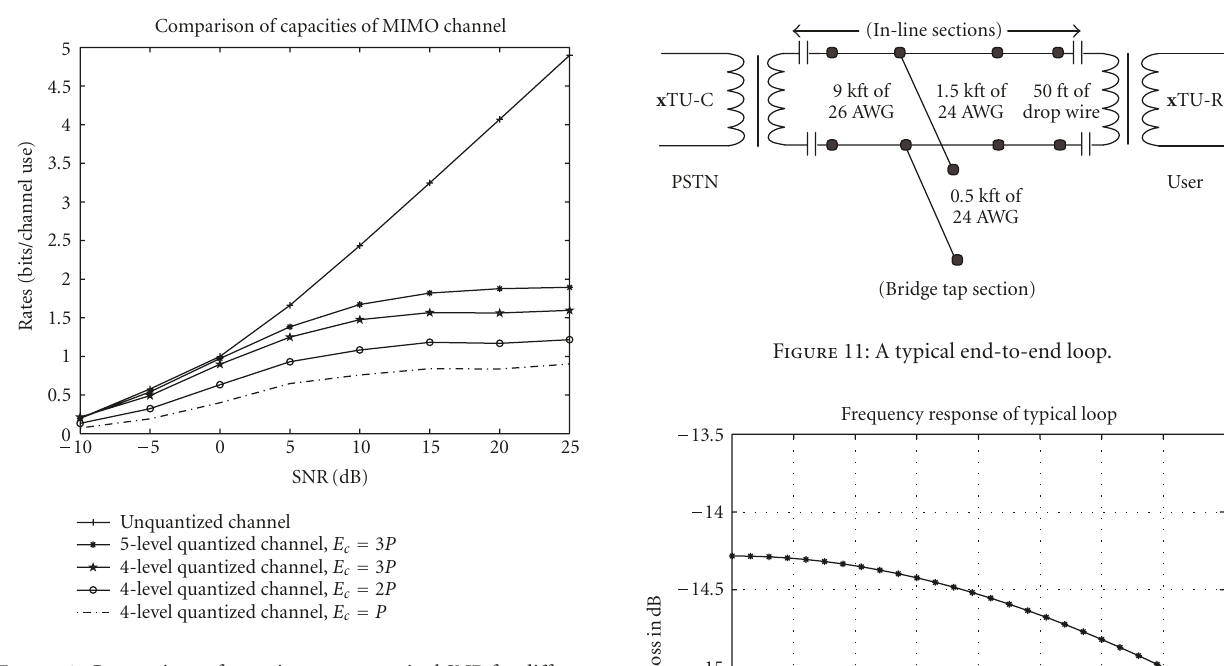
Figure 9: Comparison of capacity versus nominal SNR for di ff erent MIMO channels.